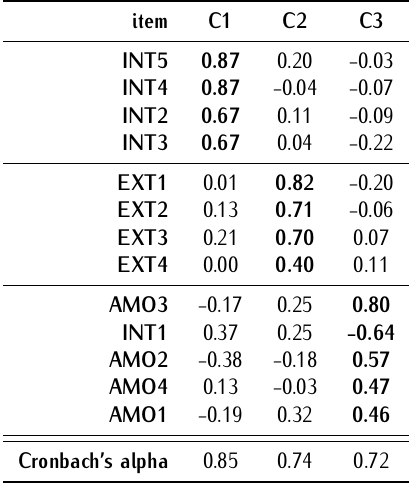
Table 3. Factor analysis for motivation scale: intrinsic motivation (INT), extrinsic motivation (EXT), and amotivation (AMO).